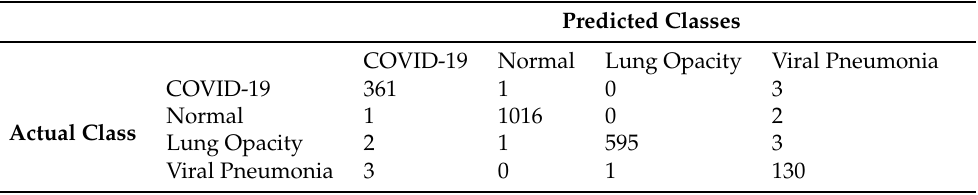
Table 10. Confusion matrix for four classes on the test dataset for the best